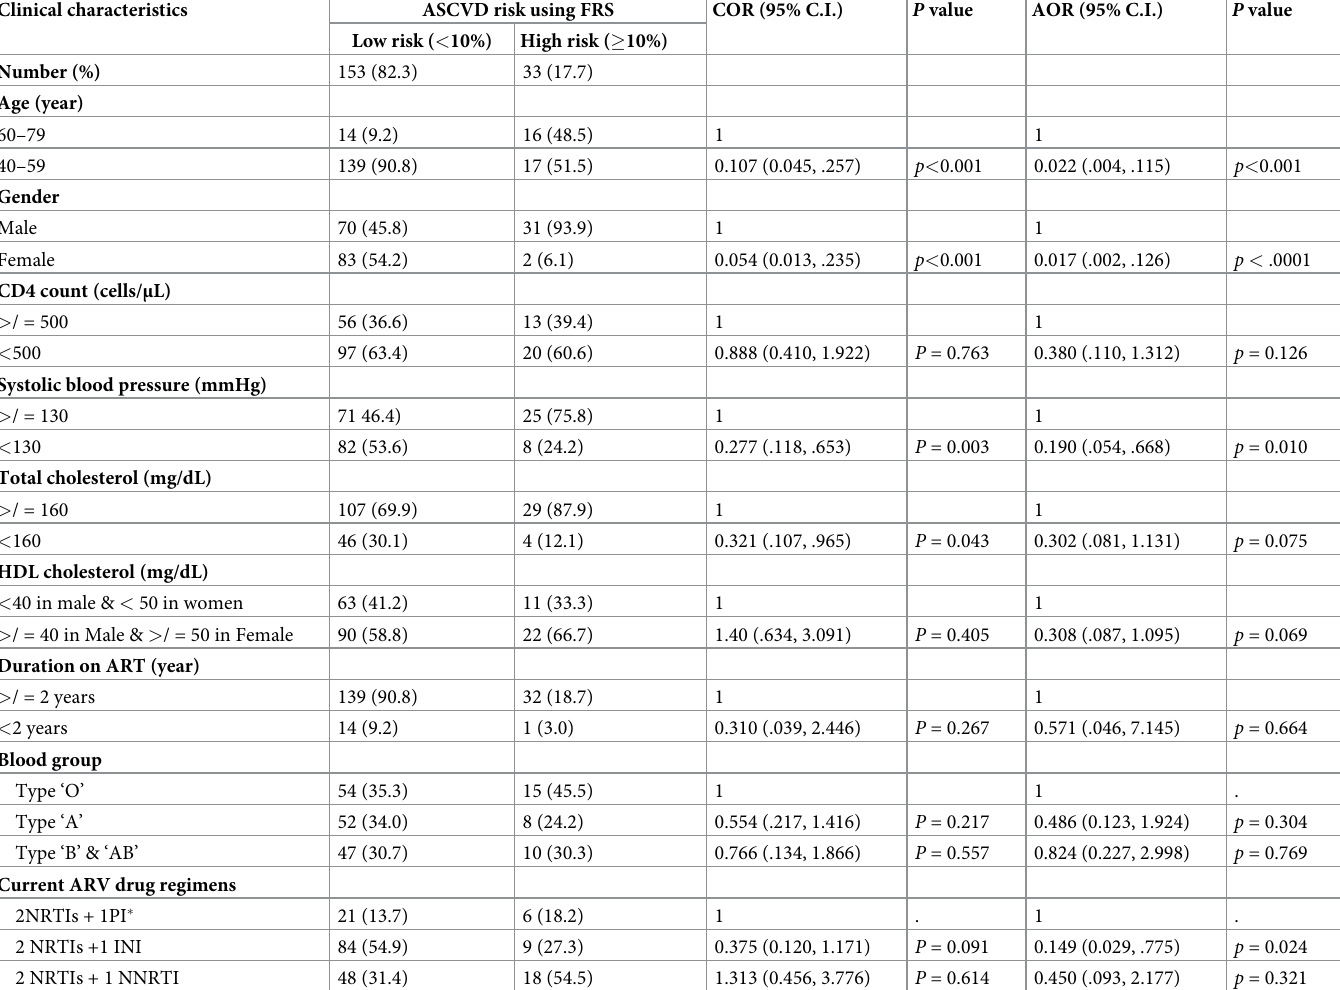
Table 4. Association between ASCVD risk using FRS and clinical characteristics among people living with HIV/AIDS age 40 75 years at Zewditu Memorial Hospi- tal, Addis Ababa, Ethiopia. Clinical